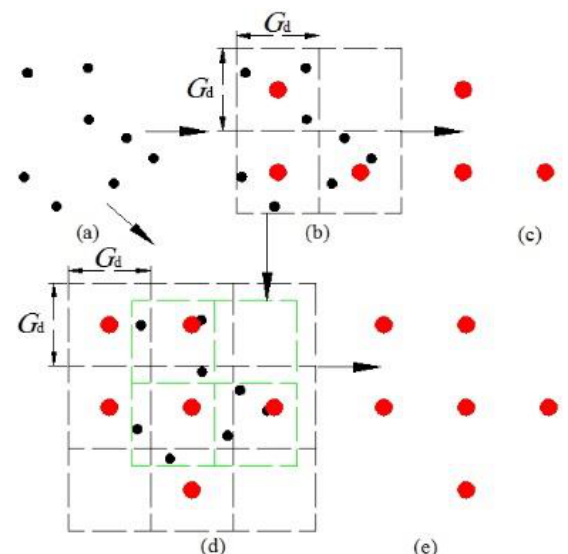
Figure 7 . The effect of the grid network structure on the number of the generated grid points. a) The point cloud, b) the first structure of the grid network, c) the generated grid points of the first structure (three points), d) the second structure of the grid network by shifting the first one in the x and y directions, e) the generated grid points of the second structure (six points). The red points are the grid points. The dashed black lines